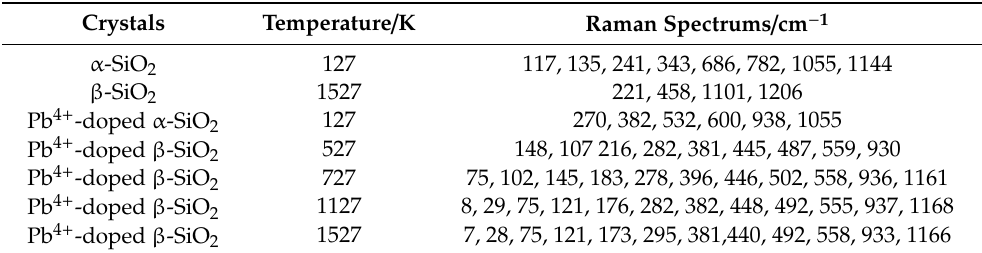
Table 1. Partial Raman